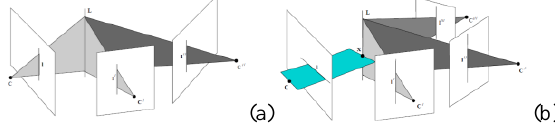
Figure 5. The geometric constraint of multiple (a) Trifocal tensor (b) Quadrifocal tensor (Hartley and Zisserman, 2003).